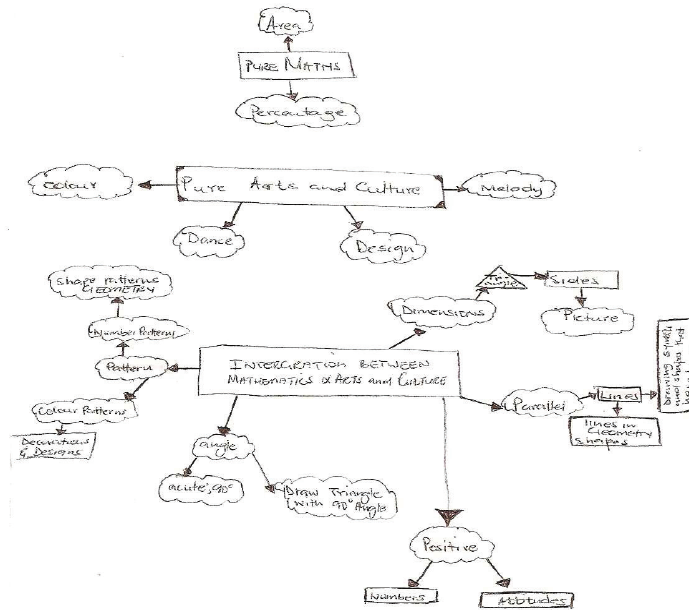
Figure 1 : The Arts and Culture teacher’s concept